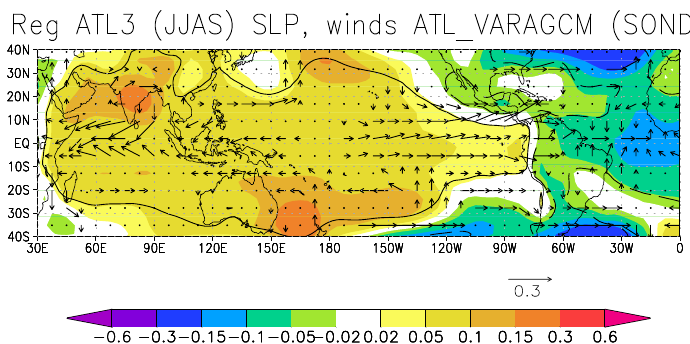
Figure 8. Regression of ATL_VARAGCM SLP and low-level winds (SOND) onto ATL3 index (JJAS). SLP anomalies that are 95% statistically significant are indicated by contours, and only statistically significant wind vector components are shown. Units are hPa for SLP and m/s for